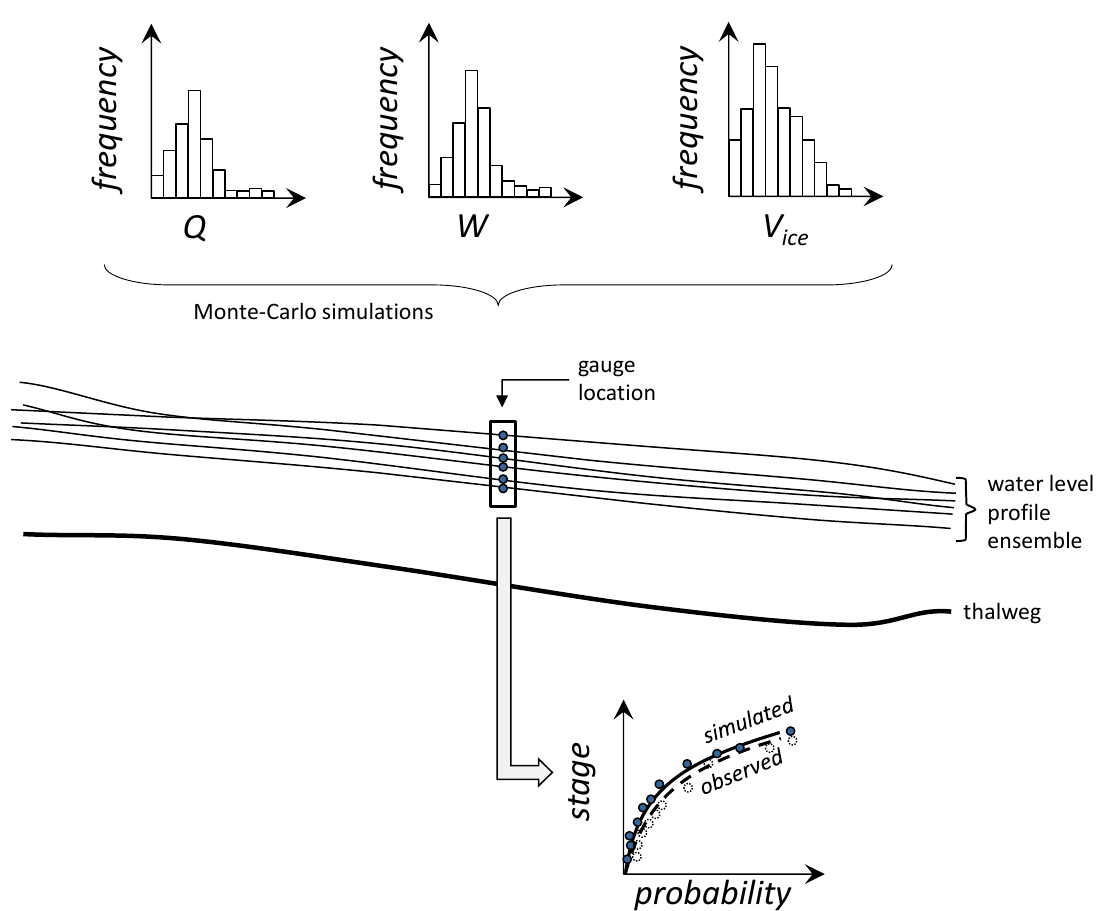
Figure 17. Monte-Carlo framework to calibrate the volume of ice, V ice , required to form ice jams along a stretch of the Oder River. Inputs to the framework include extreme value distributions of flows, Q, and water levels, W, at the upstream and downstream boundaries of the model domain, respectively. The location and scale parameters of the extreme value distribution of V ice must first be estimated. The model is then executed many times with each simulation run with a different set of randomly extracted parameter and boundary condition values. Water levels at the gauge locations are extracted from the resulting ensembles from which an extreme value distribution of stage is constructed (simulated) that is compared to the distribution of the recorded ice jam peak stages (observed). If the two distributions do not coincide, the simulations are repeated until the location and scale parameters of V ice are adjusted. When the simulated and observed stage distributions coincide, the V ice distribution is considered to be calibrated.